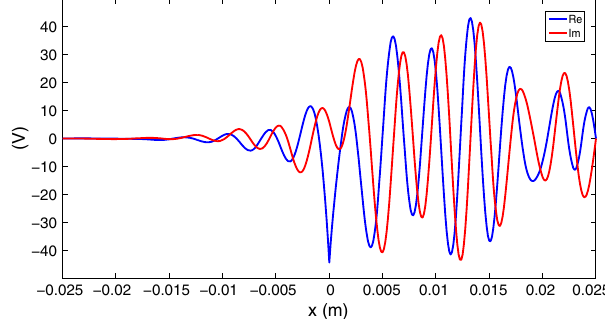
ˆ E k; s; x Þ (real part) at y ¼ g , at yp ð